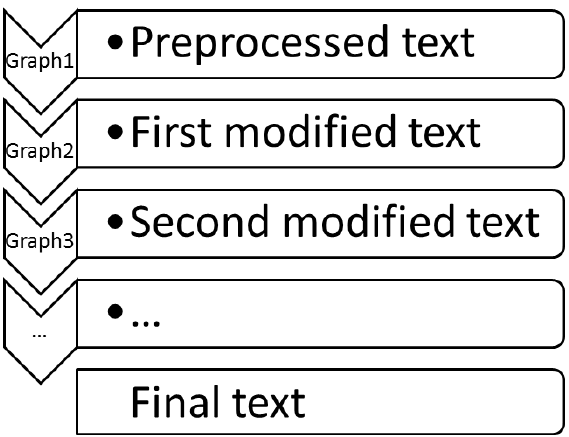
Figure 3. Cascade of graphs.